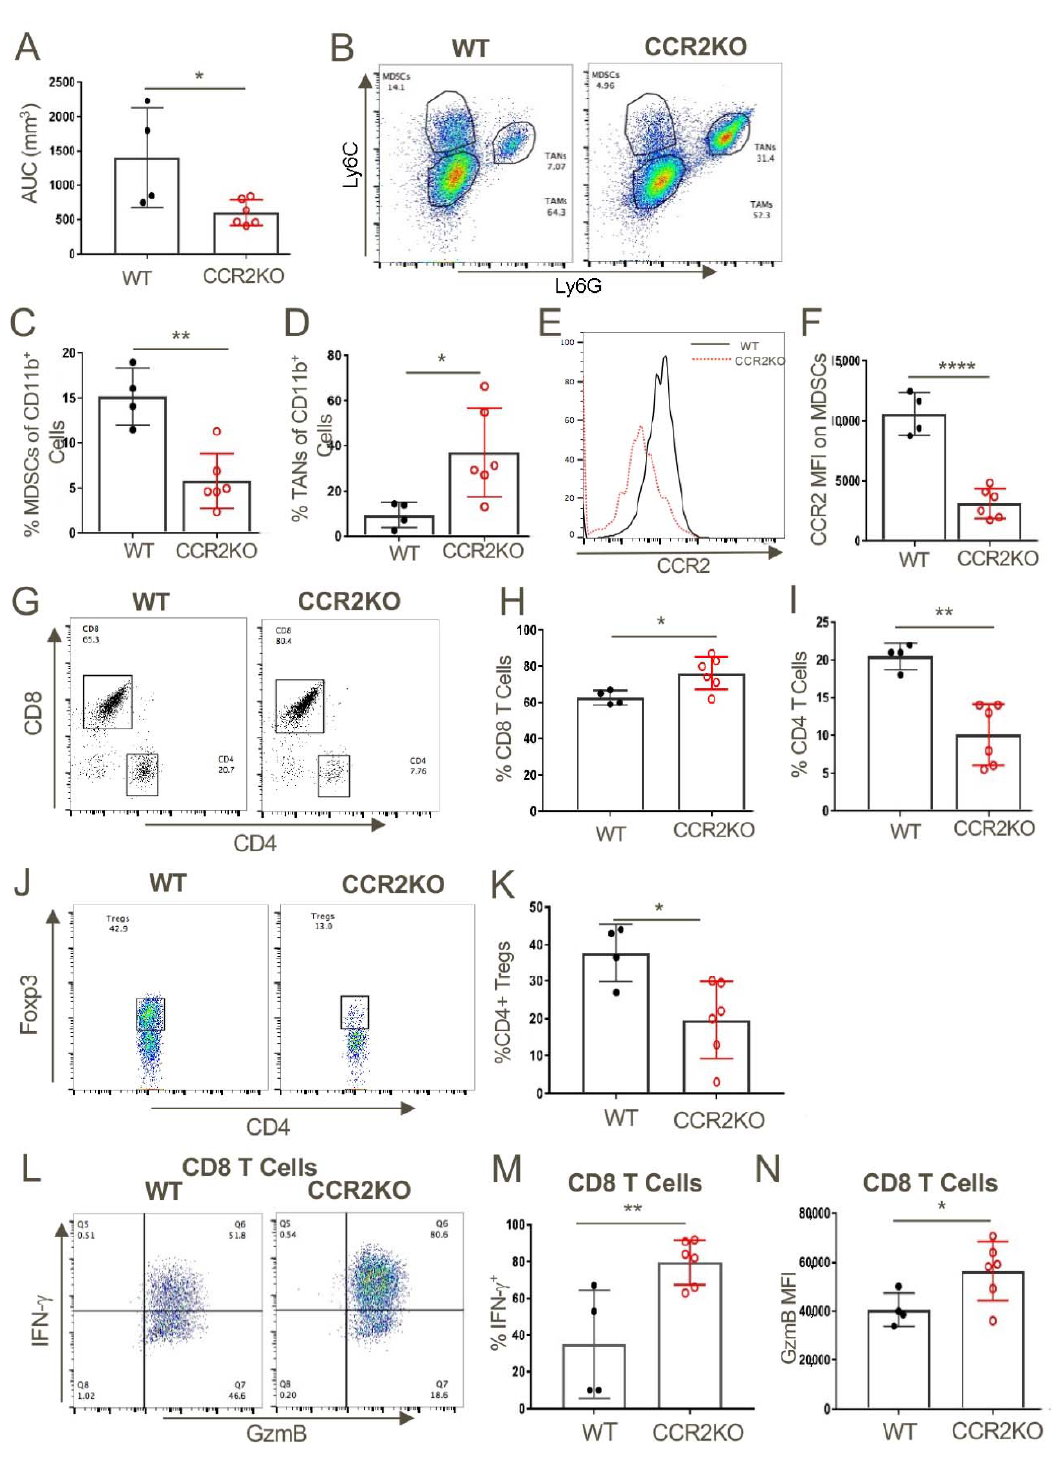
Figure 3. Genetic ablation of CCR2 reduced MDSC and Treg infiltration and increased intratumoral accumulation of activated CD8 + T cells. ( A ) TC1 tumor cells (1 × 10 6 ) were injected subcutaneous (s.c.) in WT and CCR2KO mice and tumors were measured until day 14. Analysis of the intratumoral CD11b + myeloid populations showed a significant decrease in MDSCs ( B , C ) and an increase in TAN ( B , D ). MDSCs from CCR2KO mice expressed negligible levels of CCR2 ( E , F ) as compared to MDSCs in tumors from WT mice. Tumors in CCR2KO mice also showed a higher frequency of CD8 + T cells ( G , H ) and fewer CD4 + T cell ( G , I ) and Tregs ( J , K ) as compared to WT control. Intratumoral CD8 + T cells from CCR2KO mice expressed significantly higher levels of IFN- γ ( L , M ) and GzmB ( N ) upon restimulation; * p < 0.05, ** p < 0.01, **** p < 0.001. Data are representative of three independent